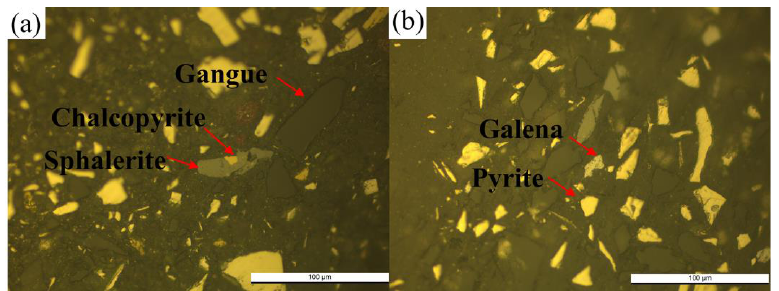
Figure 5. Occurrence state of main minerals in cyanide tailings ( a ) chalcopyrite and sphalerite intergrowth, ( b ) pyrite and galena monomer. Table 2. Analysis results of mineral composition of cyanide tailings.